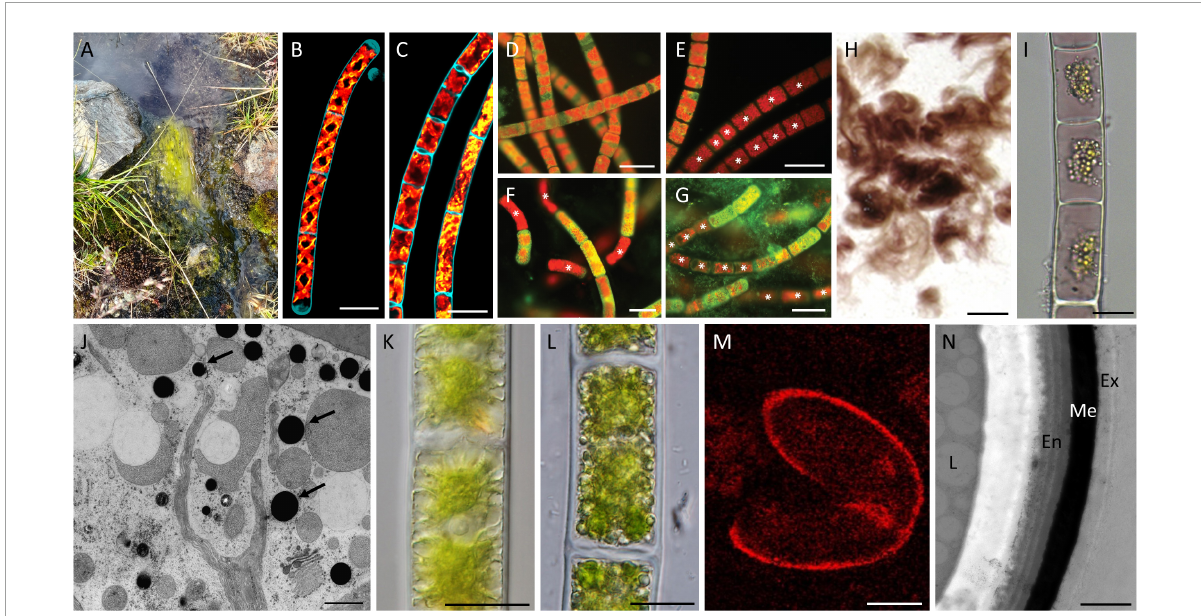
FIGURE2 Effects and adaptation mechanisms of Zygnematophyceae to high radiation and temperature extremes. (A) Zygnematophyceae mat in semi-terrestrial habitat; (B) confocal micrographs of Spirogyra sp. maintained at 22 ◦ C; (C) confocal micrographs of Spirogyra sp. maintained at 37 ◦ C with altered plastids; (D–G) Zygnema sp. stained with 0.1% Auramine O, dead cells marked with an asterisk; (D) young culture (–2 ◦ C); (E) young culture (–10 ◦ C); (F) pre-akinetes (–20 ◦ C); (G) pre-akinetes (–70 ◦ C); (H) purple Zygogonium ericetorum filaments; (I) cells of Z. ericetorum with purple pigment in the vacuoles; (J) electron micrograph of Zygnema sp. exposed to PAR + UV-A showing electron-dense particles (arrows); (K) young Zygnema sp. cells after PAR + UV-A + UV-B (PAB) treatment; (L) pre-akinetes after PAB treatment; (M) RAMAN imaging of Spirogyra mirabilis zygospore showing aromatics in cell wall; (N) transmission electron micrograph of Spirogyra mirabilis zygospore cell wall showing three-layered structure and electron-dense middle layer; Abbreviations: En, endospore; Ex, exospore; Me, mesospore; and L, lipid. Scale bars (B,C) 100 µ m; (D–G) 40 µ m; (H) 1 cm; (I,K,L) 20 µ m; (J) 1 µ m; (M) 15 µ m; (N) 1 µ m. (B,C) Reprinted from de Vries et al. (2020); (D–G) Reprinted from Trumhová et al. (2019); (H,I) Reprinted from Aigner et al. (2013); (J) Reprinted from Pichrtová et al. (2013); (K,L) Reprinted from Holzinger et al. (2018); and (M,N) Reprinted from Permann et al. (2021a). All reprinted material was published under CC-BY license and is copyrighted by the